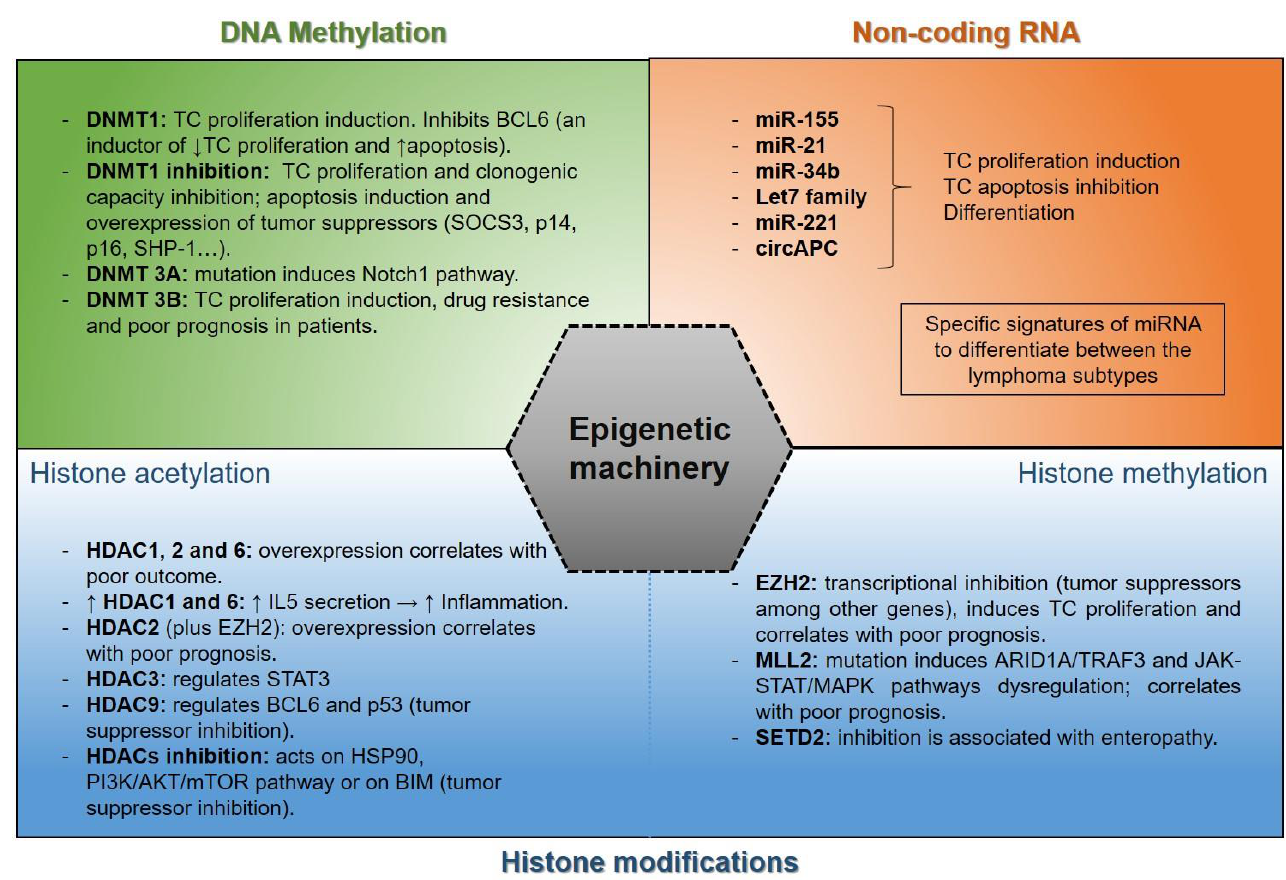
Figure 1. DNA methylation, non-coding RNA, and histone modifications as regulatory epigenetic mechanisms in lymphoma tumor cells. Table 2. Epigenetic modifications involved in lymphoma tumors.